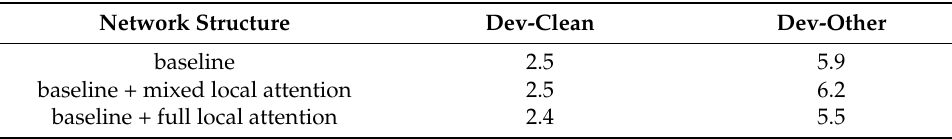
Table 3. Results of the exploratory experiments of the